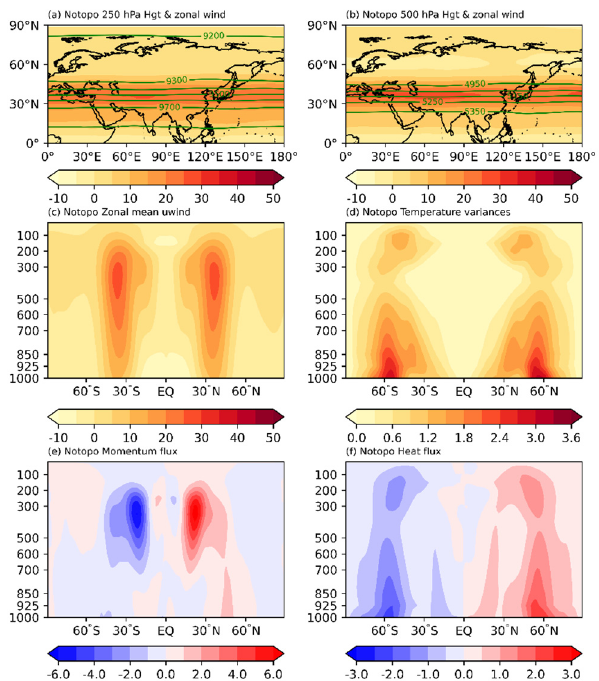
Figure 3. The climatological mean ( a ) 250 hPa geopotential height (green contour, intervals: 100 gpm, unit: gpm) and zonal wind (shaded, unit: m/s). ( b ) As in ( a ), but at 500 hPa. Pressure − latitude cross-section of ( c ) the zonal wind (unit: m/s), ( d ) meridional variances of temperature (unit: K 2 ), ( e ) eddy momentum flux (unit: (m/s) 2 ) and ( f ) heat flux (unit: m·k/s) in the Notopo test.